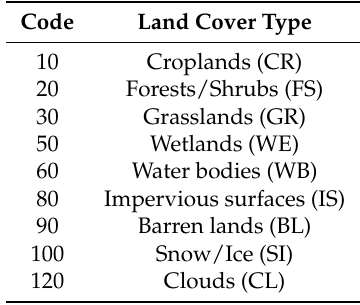
Table 1. The classification scheme used in this